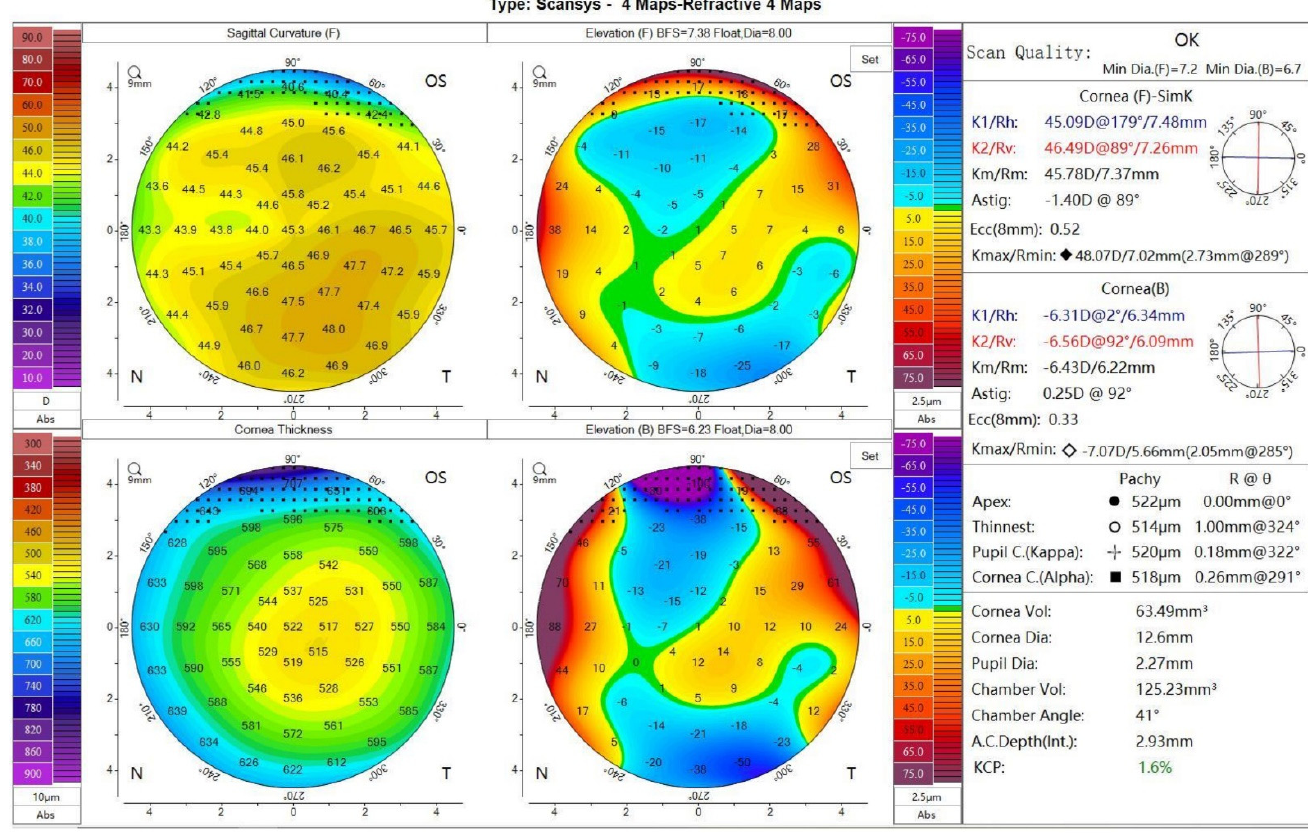
Figure 3. Scheimpflug corneal tomography in the Mediworks Scansys tomographer. Corneal tomography characterizes the elevation of the front and back corneal sur- faces and reconstructs the pachymetric mapping, which has significantly enhanced the sensitivity and specificity for detecting corneal ectasia [8,55]. A significant advantage of tomography compared to topography is the possibility to determine the true corneal power; to calculate it, it is required to assess the posterior corneal surface. In most keratometric devices, the relationship between the anterior and posterior corneal surfaces is considered as constant and estimated based on a theoretical “keratometric index”. Evaluation of the power of the posterior corneal surface is critical in IOL calculations in eyes having undergone laser vision correction. As in corneal refractive surgery, corneal tissue is re- moved for refractive purposes, and as a consequence, the altered relationship between the front and back surfaces invalidates the use of the standardized index of refraction. Moreover, recent investigations showed that in virgin eyes, the magnitude of anterior and posterior astigmatism is greater when the steep axis of the anterior astigmatism is oriented vertically [56]. Thus, neglecting measurements of the posterior corneal surface might result in overestimation of with-the-rule astigmatism, whereas in eyes with against-the-rule astig- matism, the magnitude of astigmatism can easily be underestimated. Therefore, accurate assessment of the total corneal power, and specifically its astigmatism, with corneal tomog- raphy devices could potentially increase the refractive outcome in cataract and refractive lens extraction surgery [57–60]. Currently, the Zeiss IOL Master 700, Oculus Pentacam AXL and Anterion (Heidelberg Engineering, Heidelberg, Germany) allow measurement of the posterior corneal astigmatism [56] (Figure 4). Moreover, an ultra-fast Scheimpflug camera was implemented in the Corvis ST (OCULUS Optikgeräte GmbH, Wetzlar,